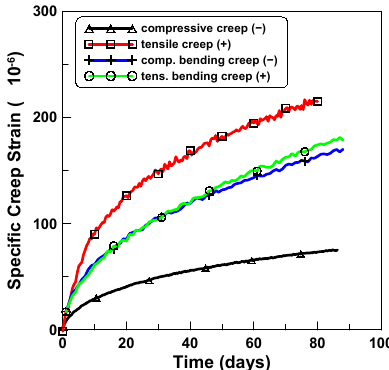
Figure 12. Comparison of creep in compression, tension, and bending creep.